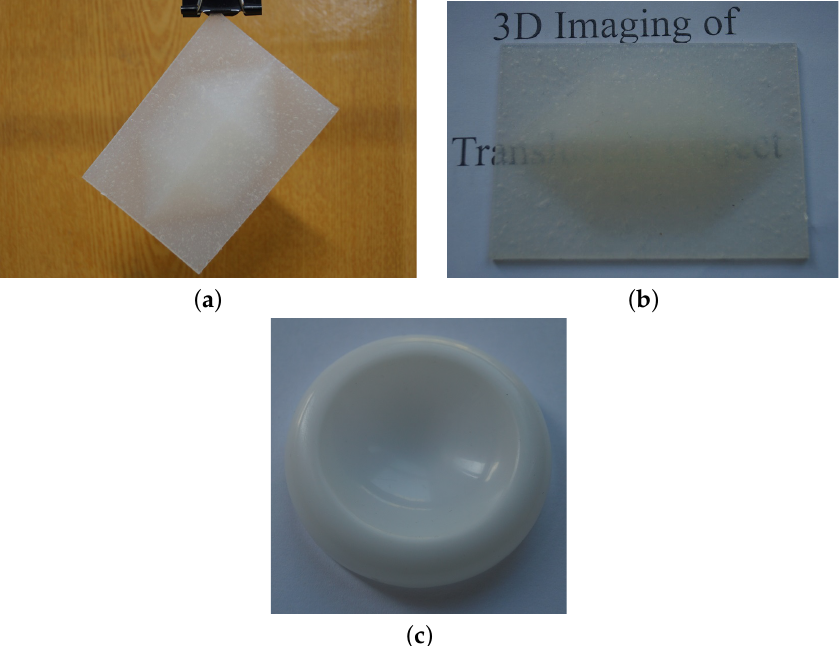
Figure 3. Original photos of selected translucent objects being measured. ( a ) Heptahedron-shape vulcanized silicone rubber. ( b ) The same object shown in ( a ) on white paper with printed letters. ( c ) Translucent plastic